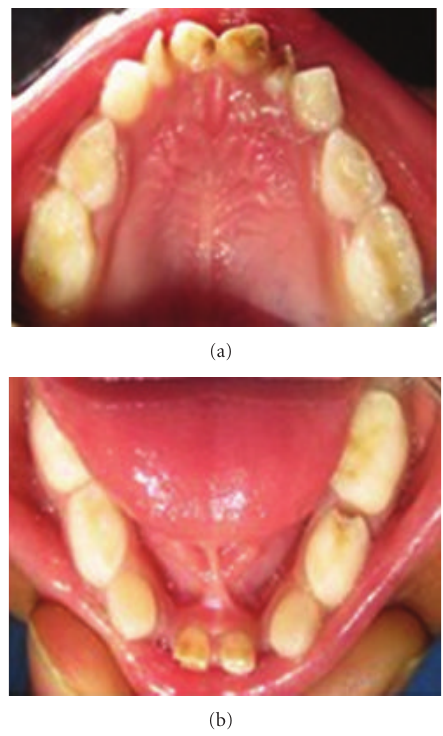
Figure 2: Intraoral photograph.